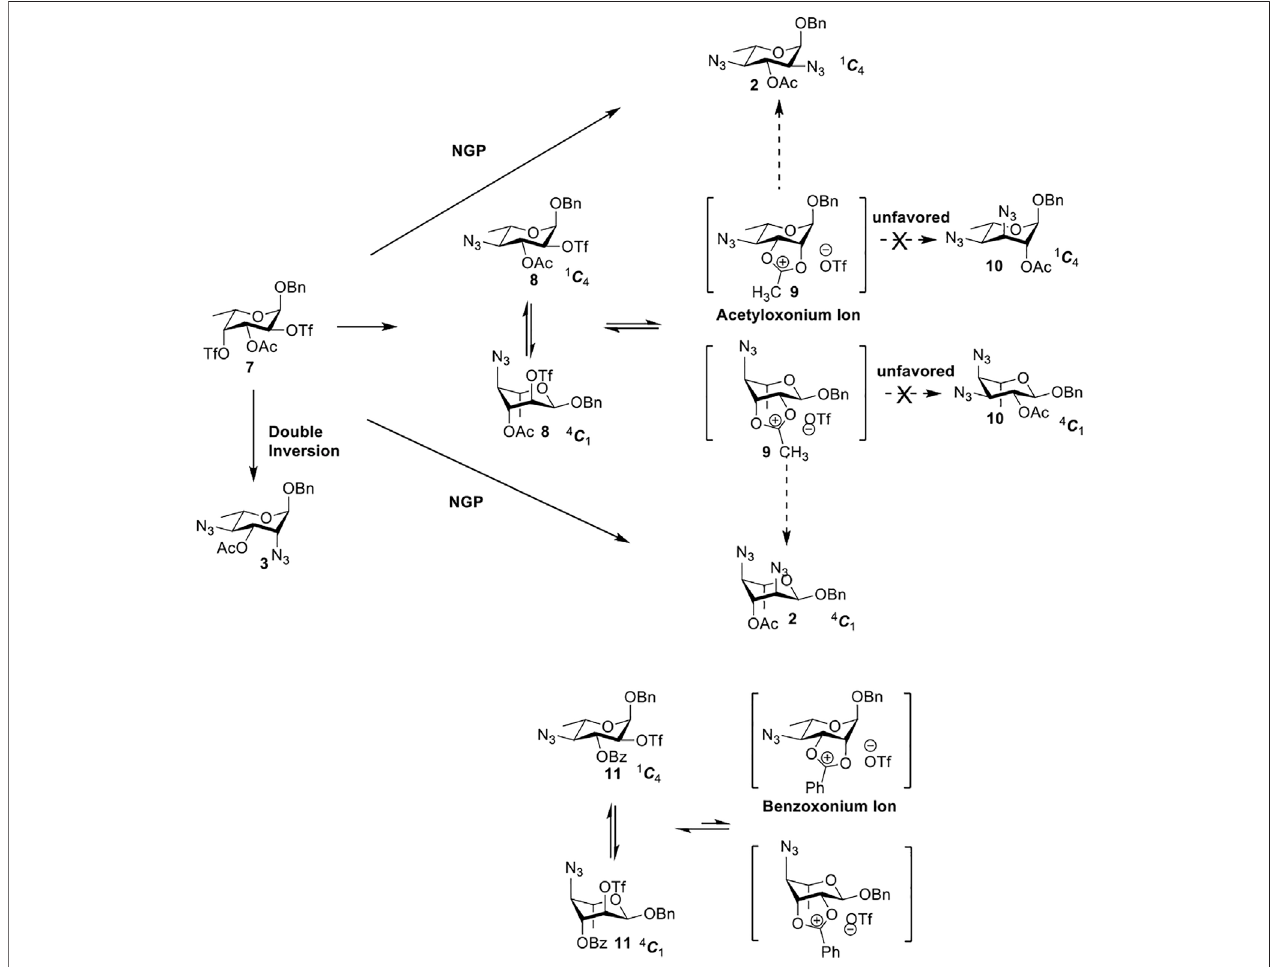
SCHEME 1 | Competition of NGP with double